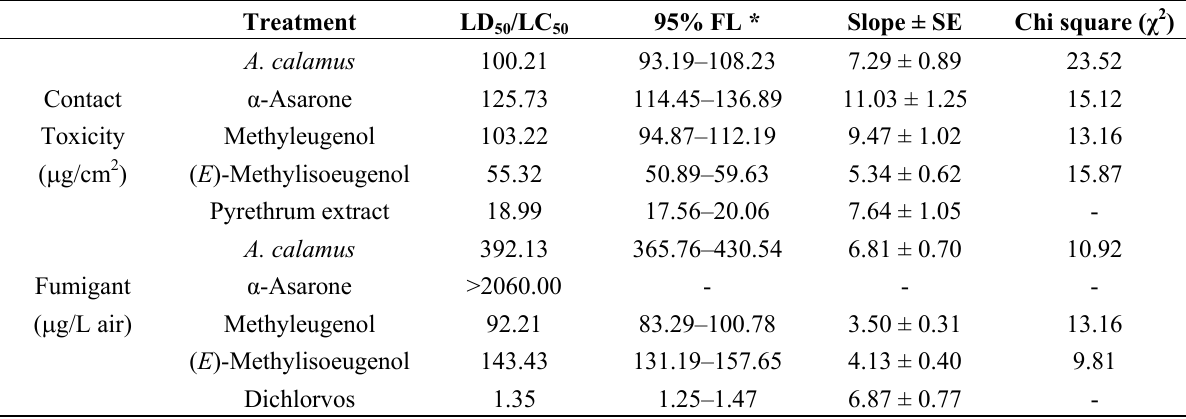
Table 2. Contact toxicity and fumigant toxicity of the essential oil of A. calamus rhizomes and its constituents against L. bostrychophila